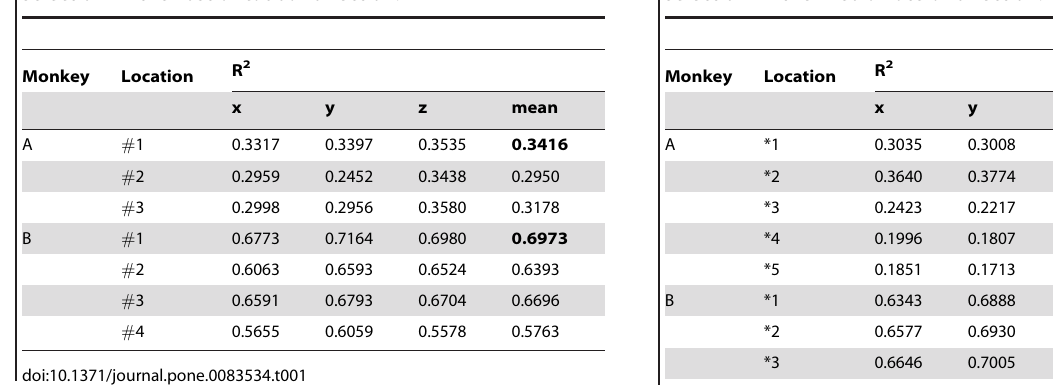
Table 1. Prediction results using location-based electrode selection in the rostral-caudal direction.